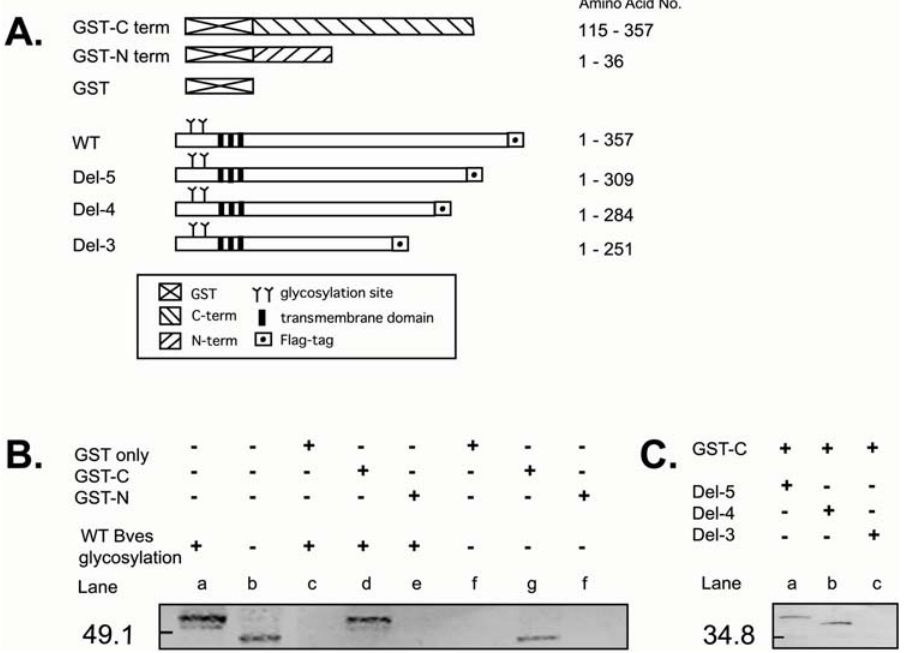
Figure 1. Bves constructs and GST pull-down assay. A, Diagram of GST-fusion proteins and deletion constructs. GST C- and N-terminal Bves proteins and serially deleted Flag-tagged Bves proteins. B, GST pull-down assay with C- or N-terminal Bves. Bacterial lysates of GST-Bves fusion proteins were reacted with COS-7 cell lysates transfected with Flag-tagged WT Bves and analyzed with Western blots using an anti-Flag antibody. The potential effects of glycosylation were also tested. Control band (WT Bves protein with or without glycosylation) are shown on lane a and b. Only GST C-terminal Bves reacted in this assay regardless of glycosylation state (lanes d and g) C, Serial deletion analysis of C-terminal interaction. GST C- terminal Bves was reacted with Del-5 Bves, Del-4 Bves and Del-3 Bves and processed for Western blotting to detect interactions. Del-5 Bves and Del-4 Bves (lanes a and b) interact with the GST C-terminal Bves while Del-3 Bves does not.